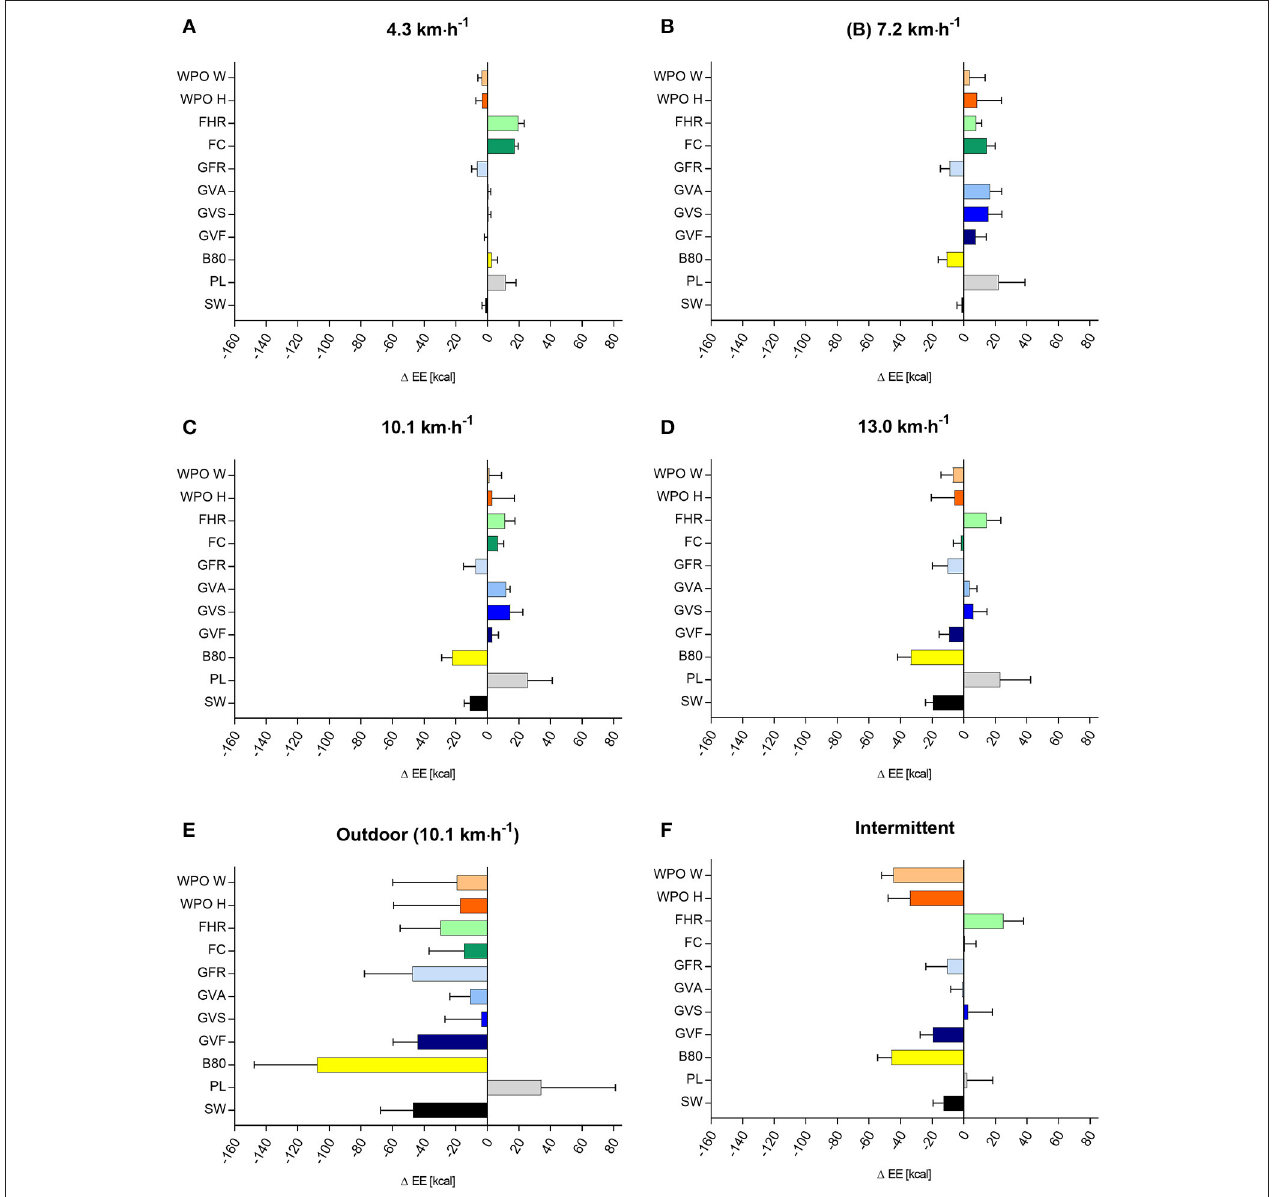
FIGURE 4 | Differences in EE (kcal) between the criterion measure and the eleven activity trackers at different running verlocities (A–F) , data are shown as mean 95% CI. Mean EE (